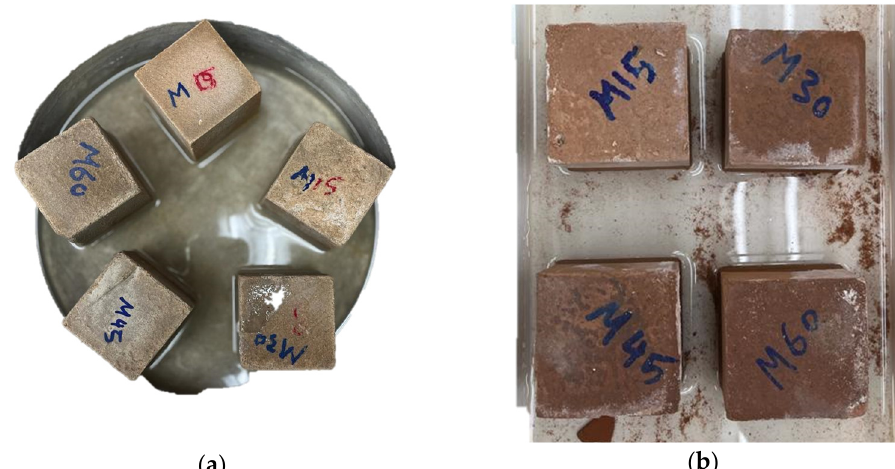
Figure 9. Virtual appearance of alkali-activated samples prepared for acid resistance test ( a ) DCP; ( b ) DCP + RM.